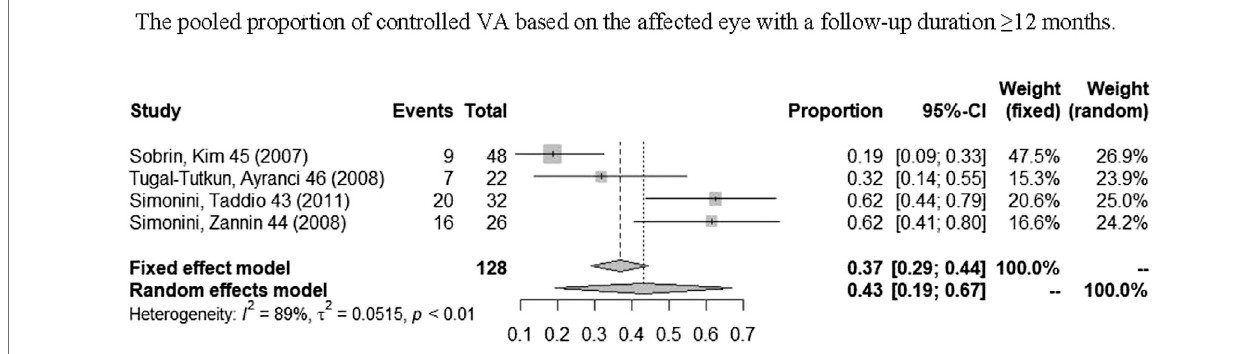
Frontiers in Pharmacology |